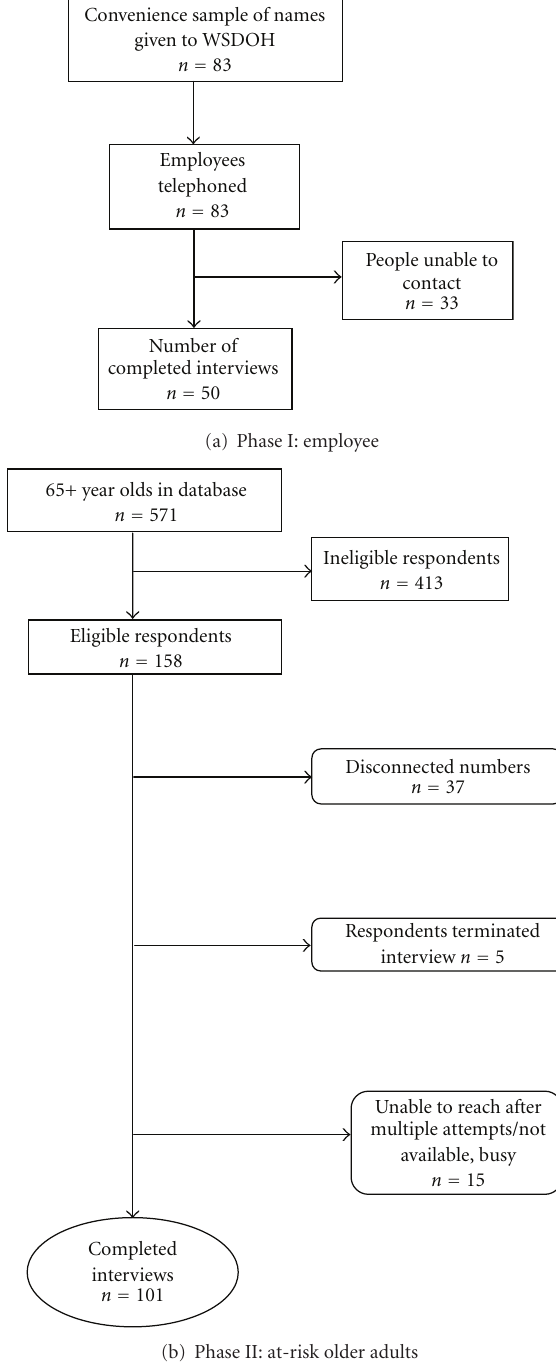
Figure 1: Recruitment of employees and older adults into the